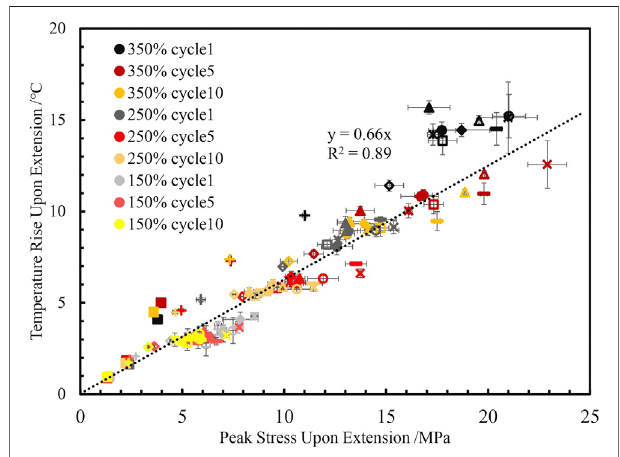
FIGURE 9 | Master-line relating peak stress upon extension and corresponding temperature rise at all tested strain percent and cycles.